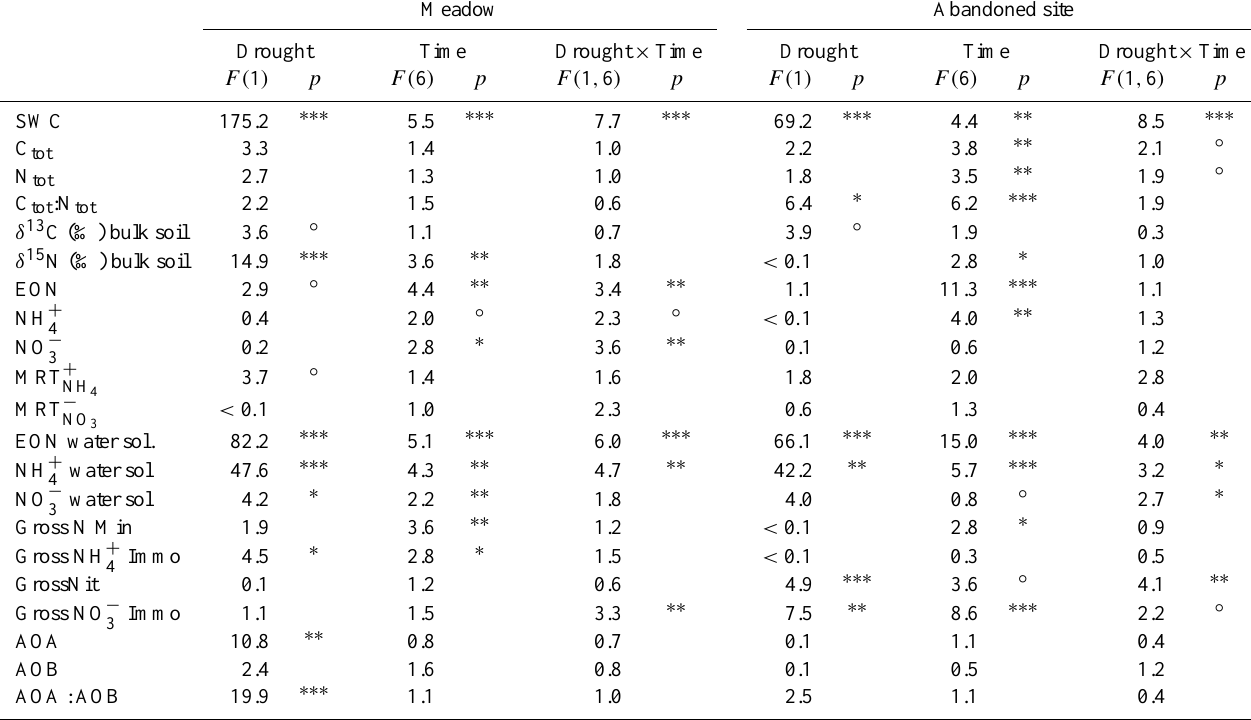
Table 3. Effects of the drought simulation and sampling time on all measured soil parameters and microbial abundances for the meadow and the abandoned site assessed by repeated-measures ANOVA ( n = 28); within-factor was plot identity ( n = 4); asterisks mark levels of significance: ◦ = p < 0 . 1; ∗ = p < 0 . 05; ∗∗ = p < 0 . 01; ∗∗∗ = p < 0 .